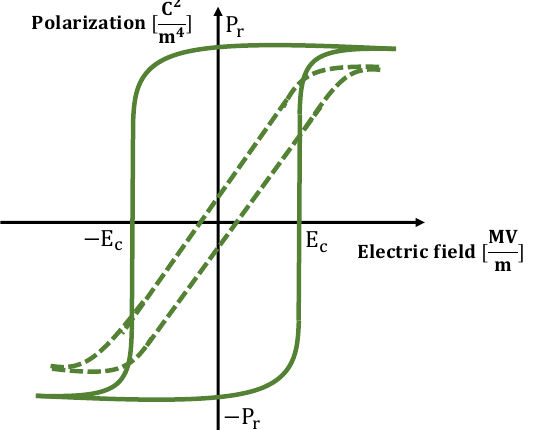
Figure 1. Electric field polarization hysteresis loops for a ferroelectric polymer (e.g., the PVDF, solid line) and for a relaxor ferroelectric polymer (e.g., the P(VDF-TrFE-CTFE), dashed line). P r and E c indicate the remnant polarization and the coercive field,